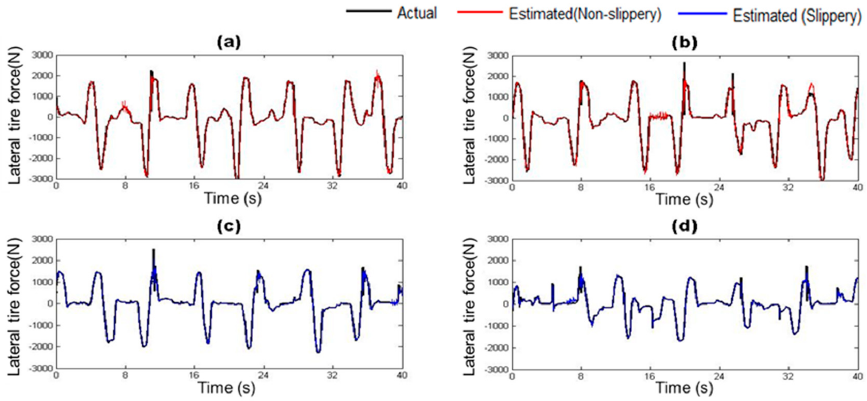
Figure 12. Estimated Lateral Tire Force depending on road surface condition: ( a ) Dry asphalt; ( b ) Gravel; ( c ) Wet; and ( d ) Snowy.